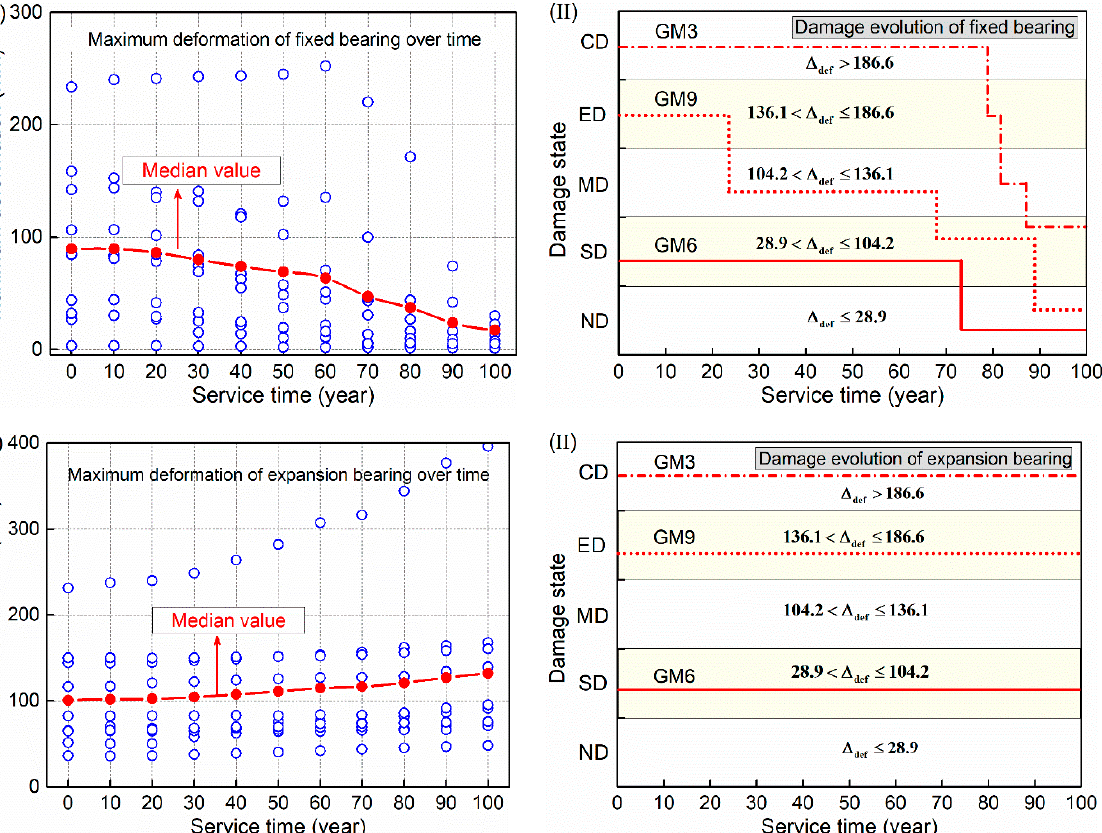
Figure 19. Peak displacement response over time and damage distribution of abutment: ( a ) left abutment; ( b ) right abutment.